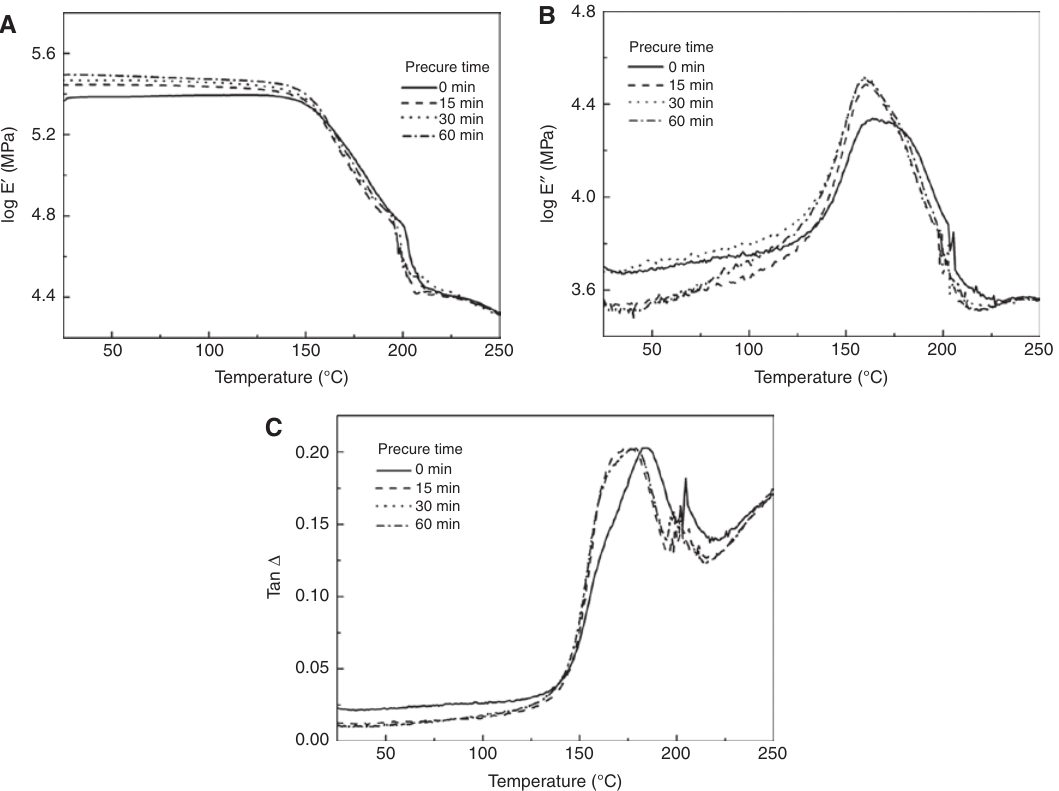
Figure 5: DMA results of the carbon/benzoxazine laminate with different precure time of the